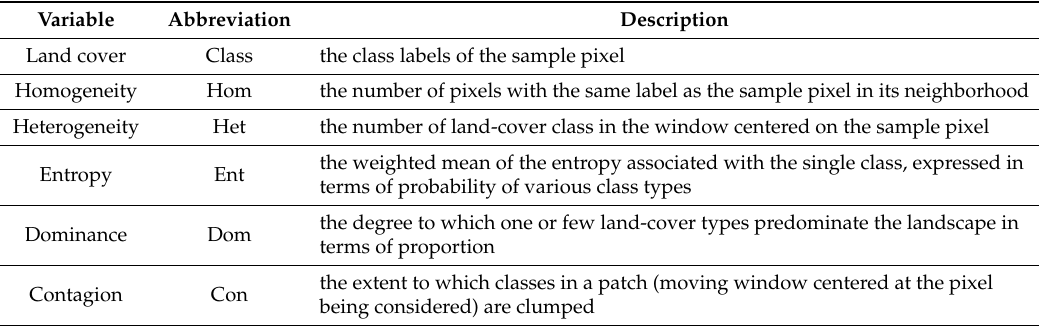
Table 2. Class occurrence pattern